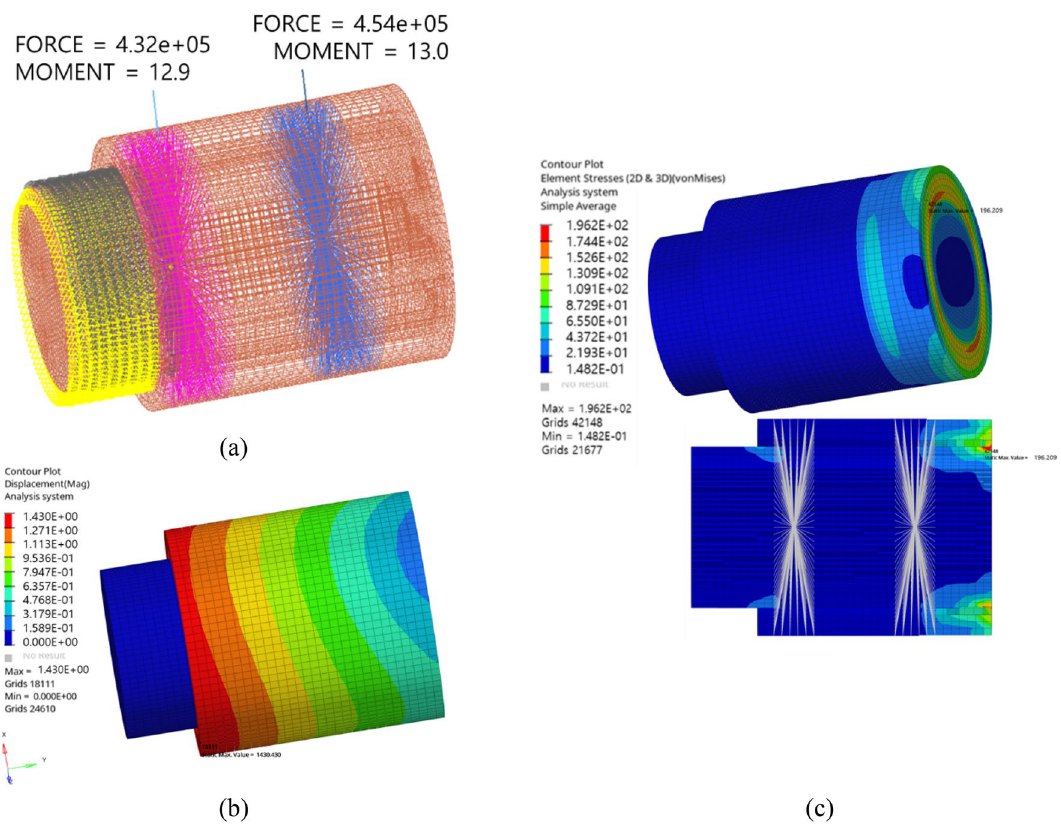
Figure 6. Finite element analysis and results of the flexible pin model: ( a ) boundary conditions and constraints (in kN and Nm), ( b ) displacement (in mm), and ( c ) von Mises stress (in